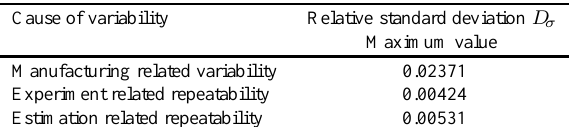
Table 6 Comparison of values of relative standard deviation of natural